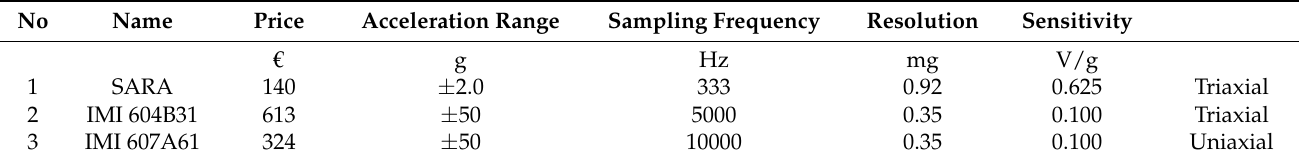
Table 4. Comparing a SARA with habitual accelerometers for the SHM of